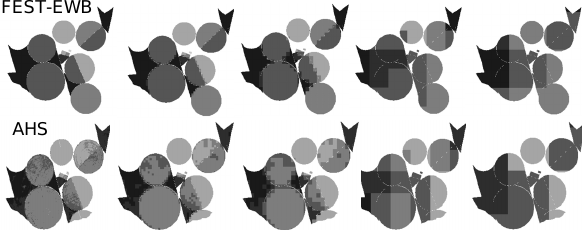
Fig. 6. RET from FEST-EWB (on top) and LST from AHS (below) at the different spatial resolutions of 10m, 50m, 100m, 500m and